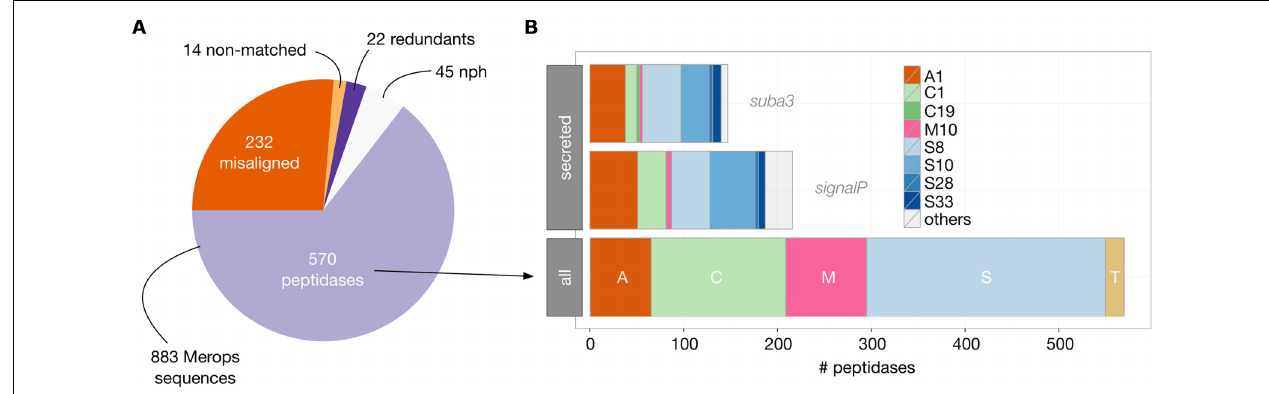
FIGURE 4 | Identification and distribution of Arabidopsis peptidases as inferred from MEROPS 9.11 database andTAIR10 genomic data. (A) BlastP analysis (see Materials and Methods) of the 883 MEROPS sequences revealed 570 actual peptidases in Arabidopsis genome; the other MEROPS sequences did not have a perfect match in the genome (misaligned and non-matched), were duplicated (redundant), or were non-peptidase homologs